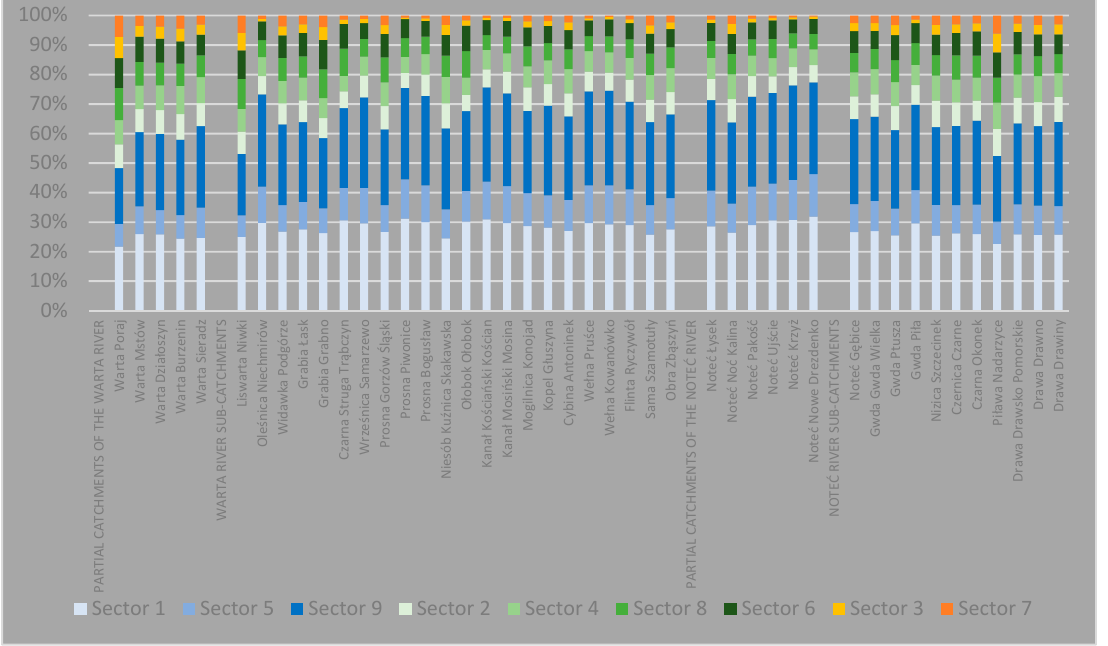
Figure 6. The percent share of separated types of the winter maximum specific runoff (WMAXq) dependencies between analyzed sub-catchments and the Gorzów Wielkopolski gauge closing the Warta River catchment (WRC) (in the hydrographic order).